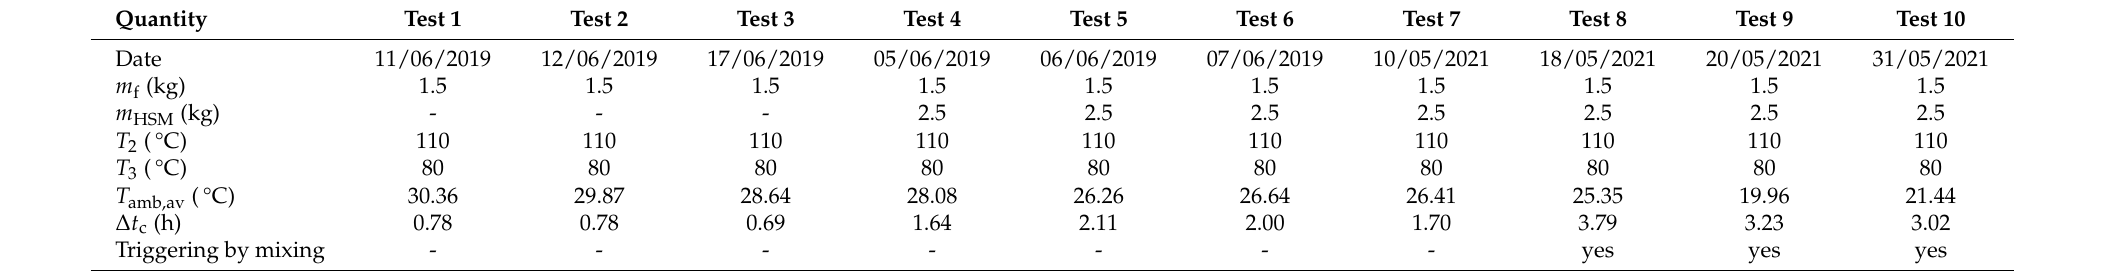
Table 7. Summary of the tests carried out with silicone oil and silicone oil + HSM during the cooling